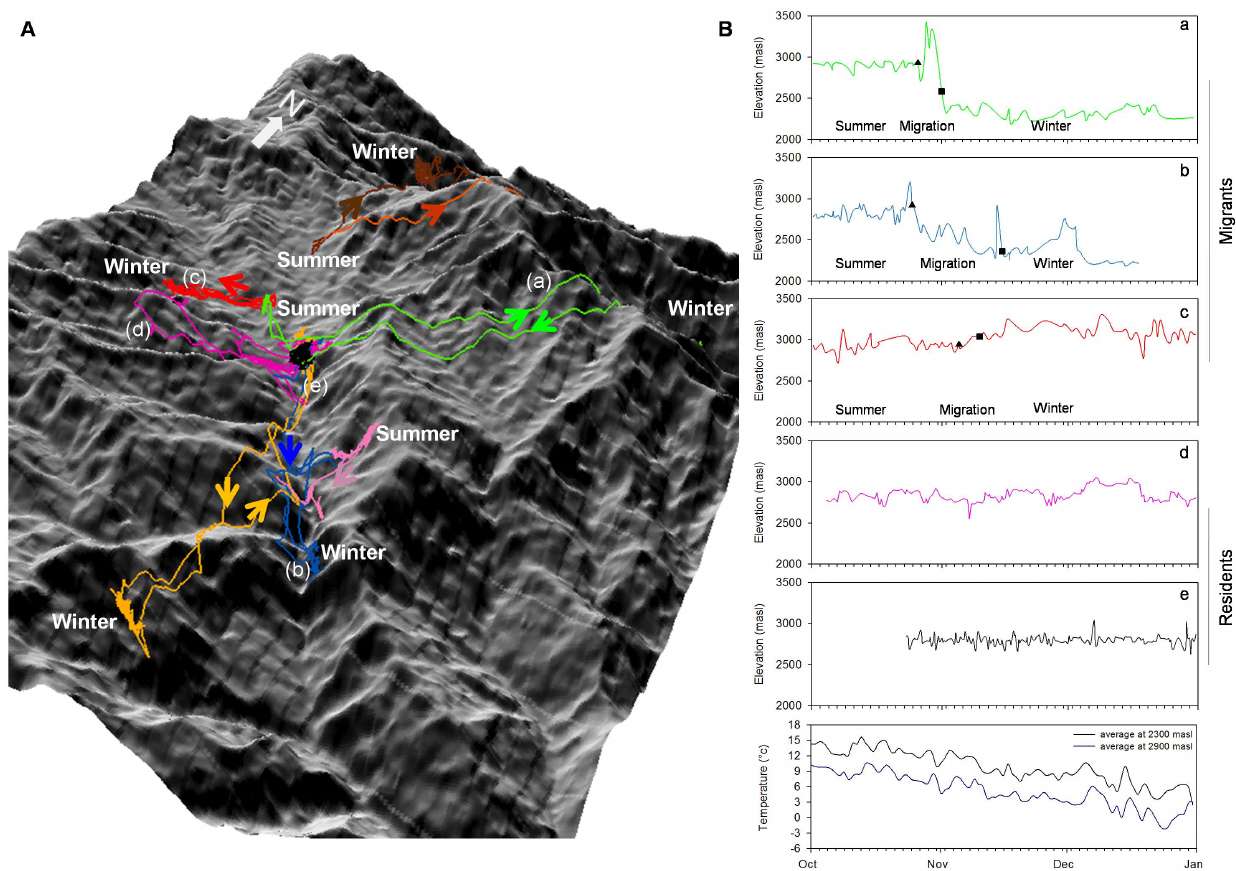
Figure 1. Migration patterns for 8 individual (different colours) tragopans (A). Arrows show direction of movement, and ‘Summer’ and ‘Winter’ denote summer breeding and wintering grounds. Elevation profiles (B) for 5 tragopans showing the initiation of migration (closed triangle) and end of migration (closed square). Individuals are identified by small letters ‘a’, ‘b’, ‘c’, ‘d’, ‘e’ on both (A) and (B). Temperature profiles are for October to December 2009 and January 2010 at 2300 (black line) and 2900 (blue line)